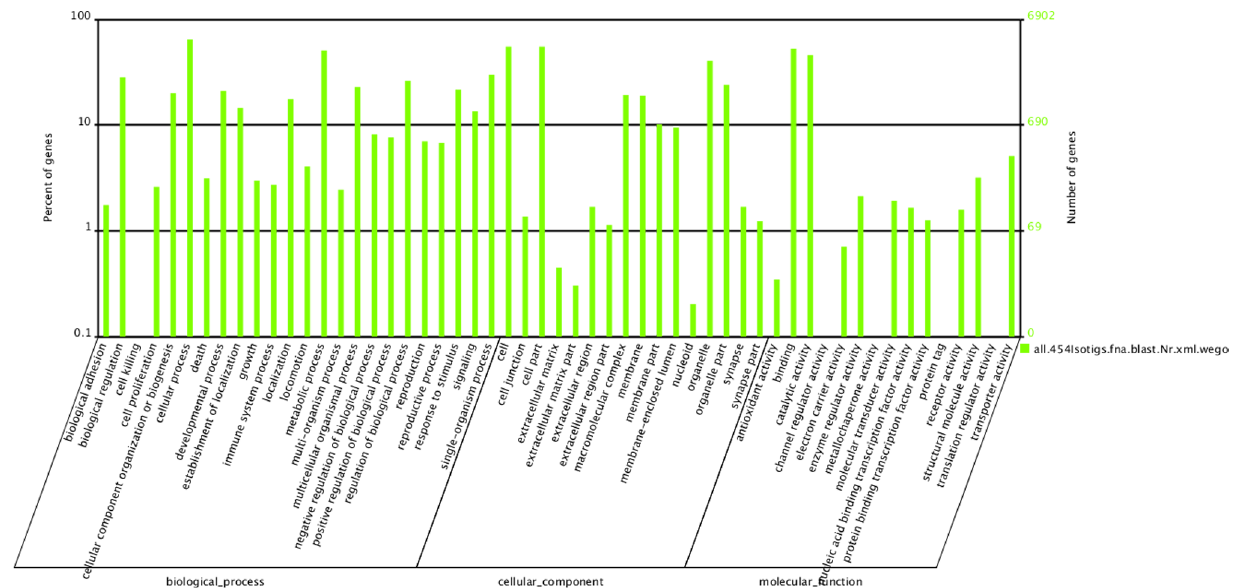
Figure 3. Histogram of GO classifications. Results summarized in three main categories: biological process, cellular component, and molecular function. Left y-axis indicates percentage of a specific category of genes in each main category. Right y-axis indicates number of genes in a category.